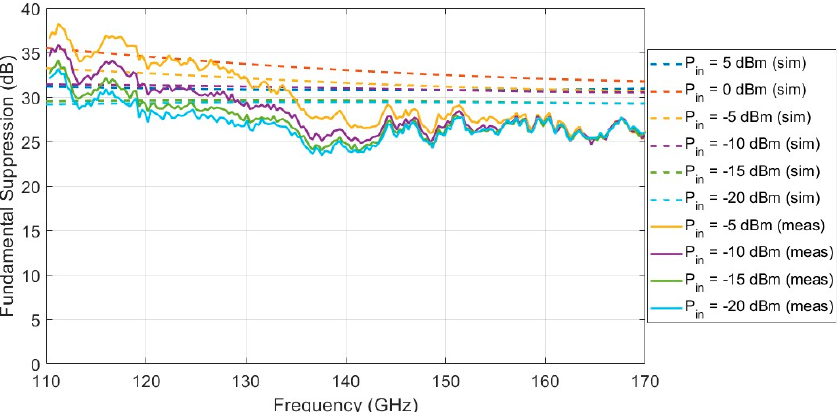
Figure 10. Incremental output voltage change for different input powers applied. Each trace corre sponds to a different frequency (120 GHz, 130 GHz, 140 GHz, and 150 GHz). The DC consumption for the PD was measured to be 11 mW.